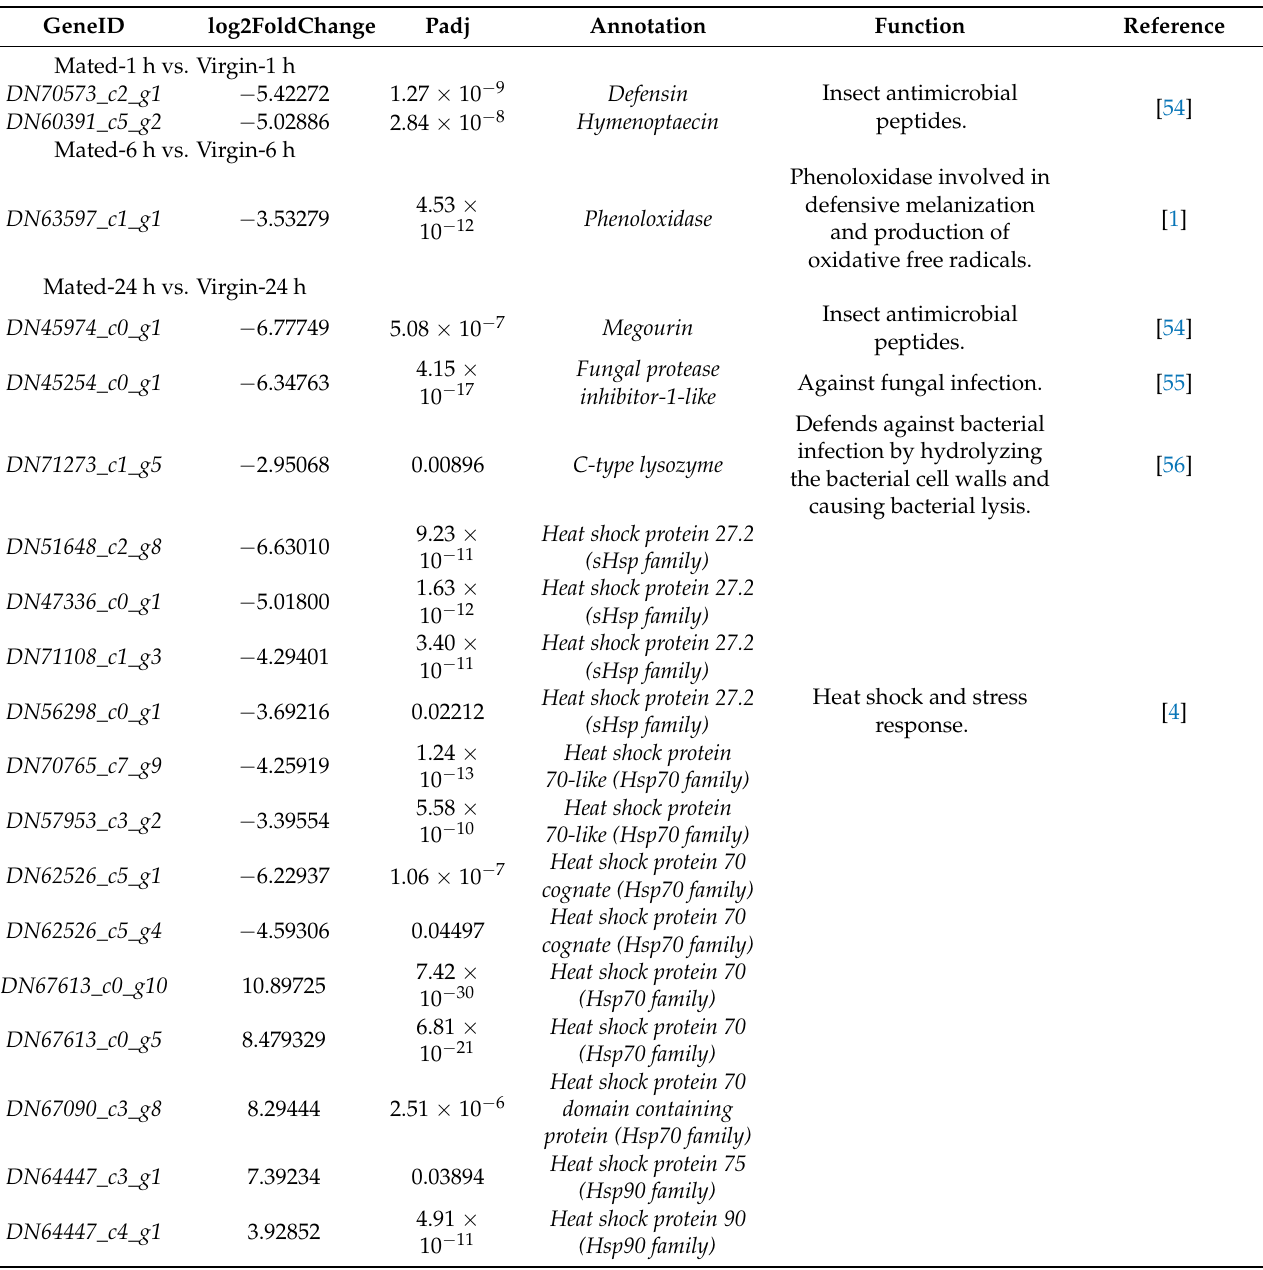
Table 3. Mating-induced expression changes in genes related to survivorship in C. chuxiongica females. GeneID log2FoldChange Padj Annotation Function Reference